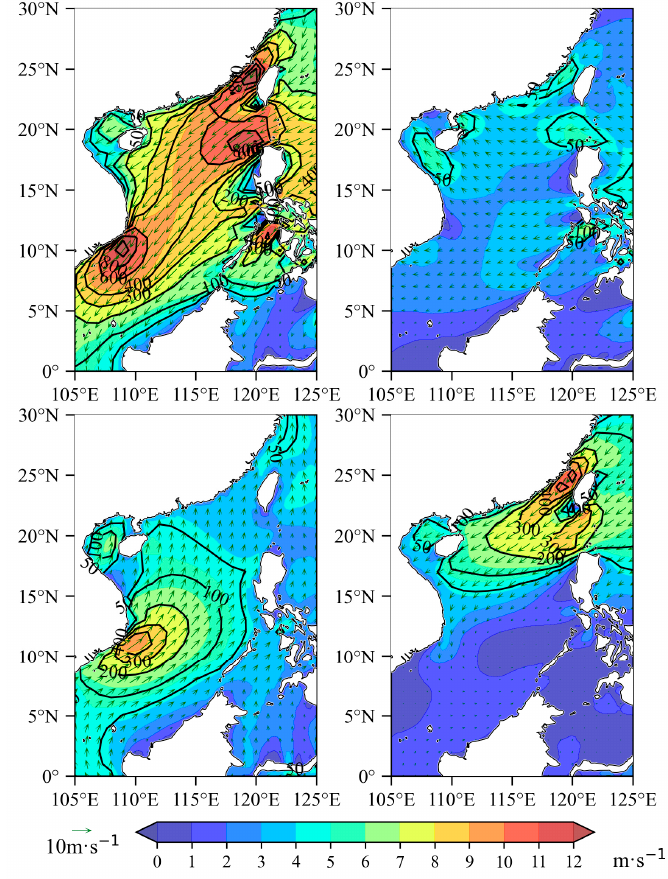
Figure 3. The seasonal mean distribution of wind (shaded, vector, and unit: m ‧ s − 1 ) and wind power density (contour, unit: W ‧ m − 2 ) over the SCS from 1979 to 2021.